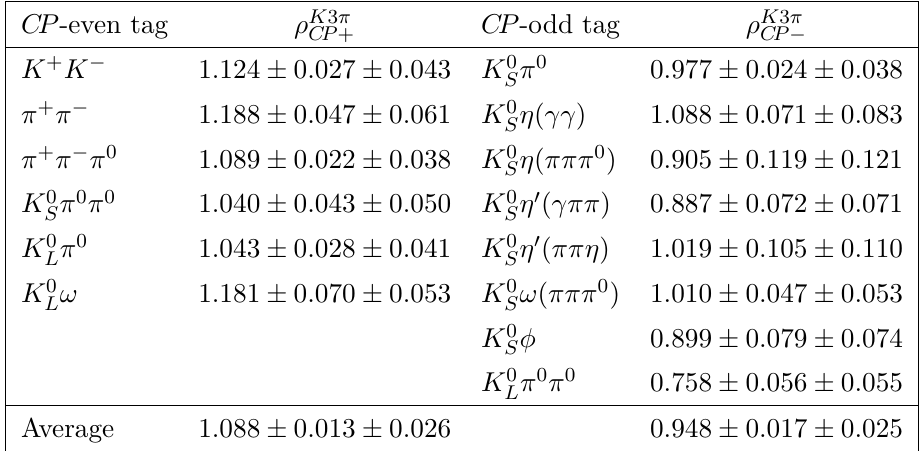
shown for individual tags, and averaged. The uncertainties are statistical Table 8 . Results for ρ K 3 π CP ± and systematic,